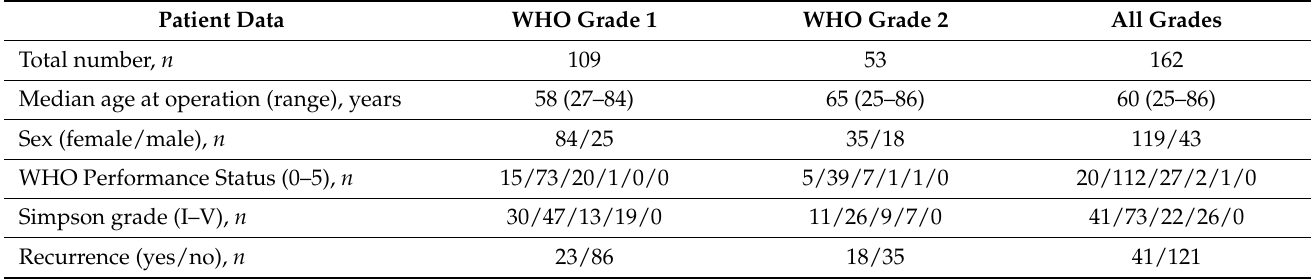
Table 2. Patient